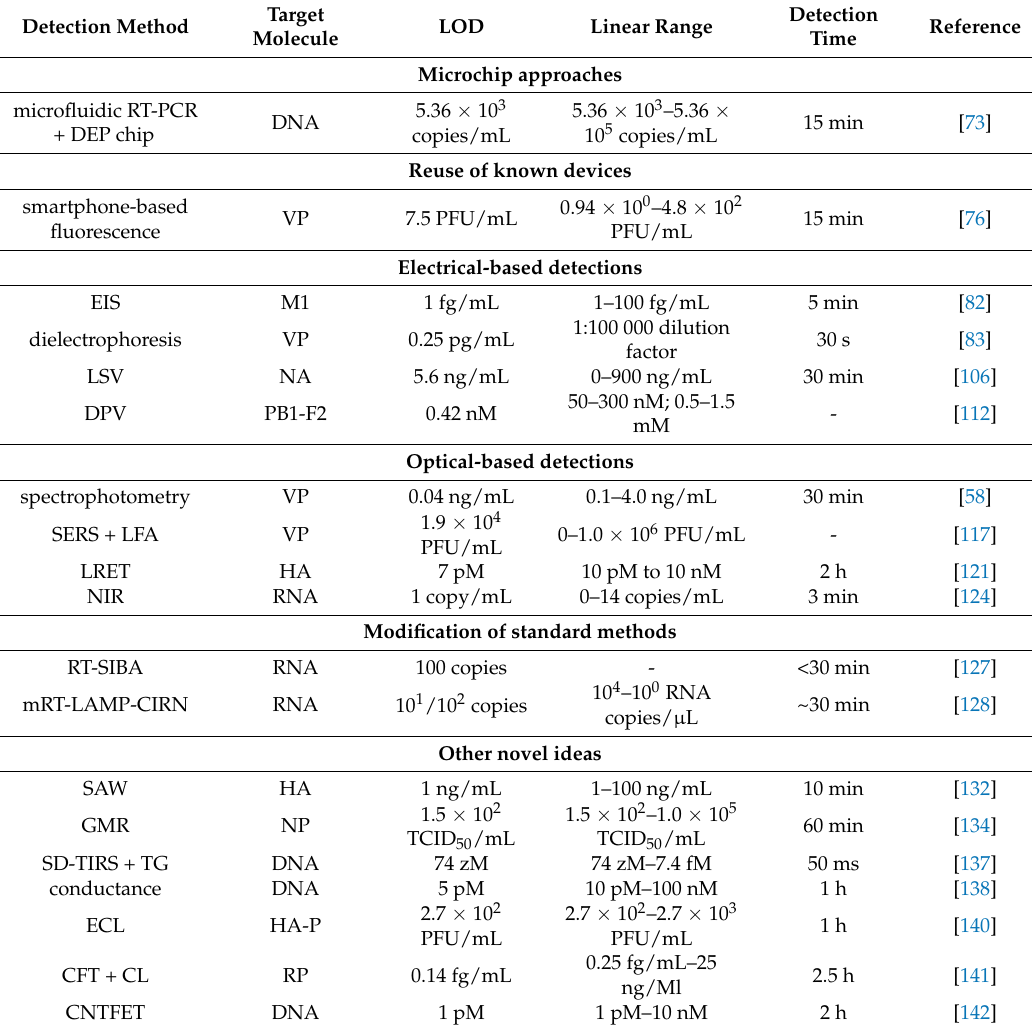
Table 2. Comparison of novel detection methods of influenza